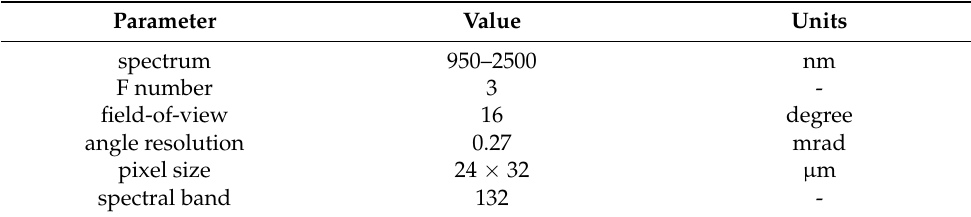
Table 1. Specifications of the spectrograph